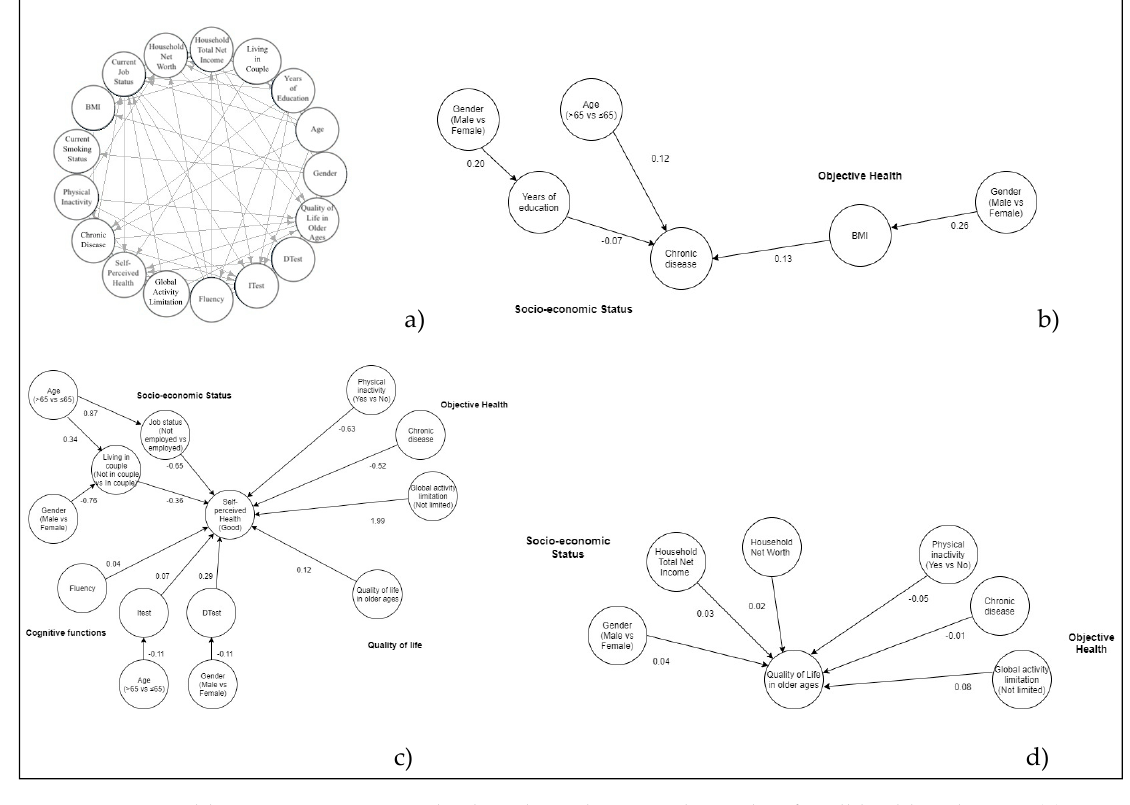
Figure 1. Additive Bayesian networks describing the interrelationship for all health indicators ( a ), chronic diseases ( b ), Self-perceived health ( c ), quality of life (QoL) ( d ) for Italian elderly. Source: The Survey on Health, Aging, and Retirement in Europe, wave 6th, 2015 year. BMI = Body Mass Index, Itest = Immediate verbal recall test, Dtest = Delayed verbal recall